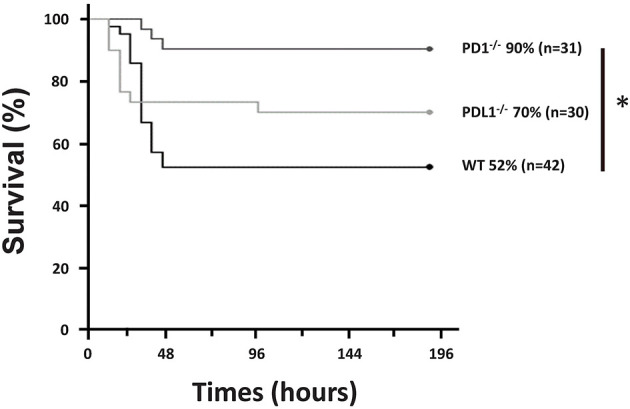
PD1 deficiency improved survival after cecal slurry (CS). C57BL/6 WT and PD1 and PDL1 deficient mice were subjected to CS, and survival was recorded. PD1−/− mice had a 90% survival rate compared to WT counterparts who only had 52% survival over a 7-day survival study. Those with deletion of PDL1 had a survival of 70% which was not significantly improved from the WT group. (*P < 0.05 vs. WT, log-rank survival analysis; n = 31–42/group).